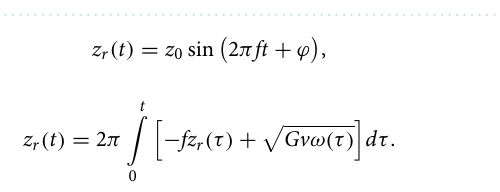
Figure 3. Roughness on the road (( a ) Case 1; ( b ) Case 2; ( c ) Case 3; ( d ) Case